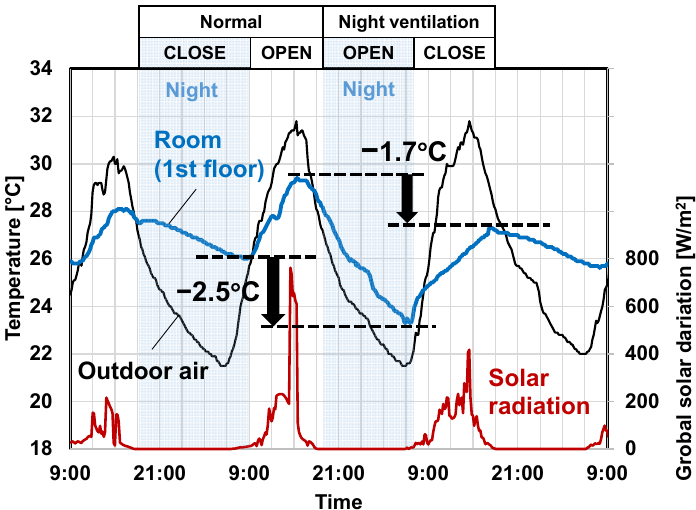
Figure 13. Measured results of the night natural ventilation experiment.